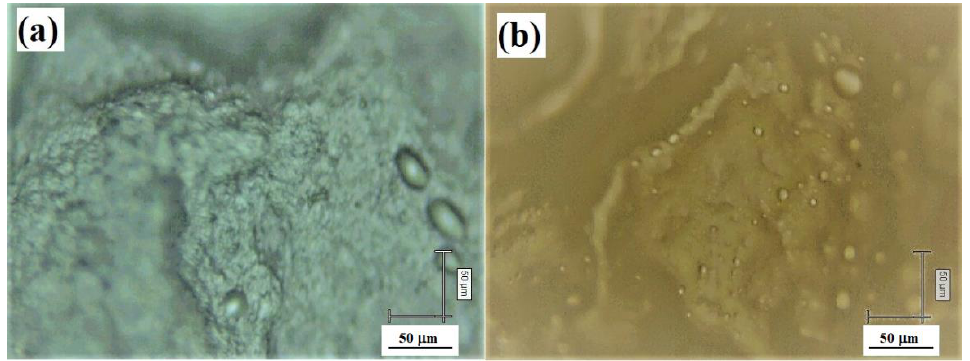
Table 3. Assignment of the vibrational bands in Raman spectra of synovial fluid accumulated as pellet deposition in the ten-year-old retrieved prosthetic (Figure 7C,D).